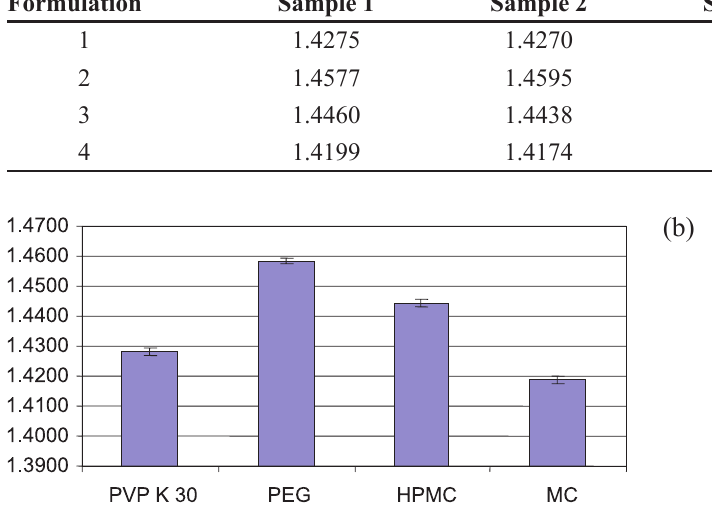
TABLE II - True density values obtained for the formulations produced. SD: standard deviation Formulation